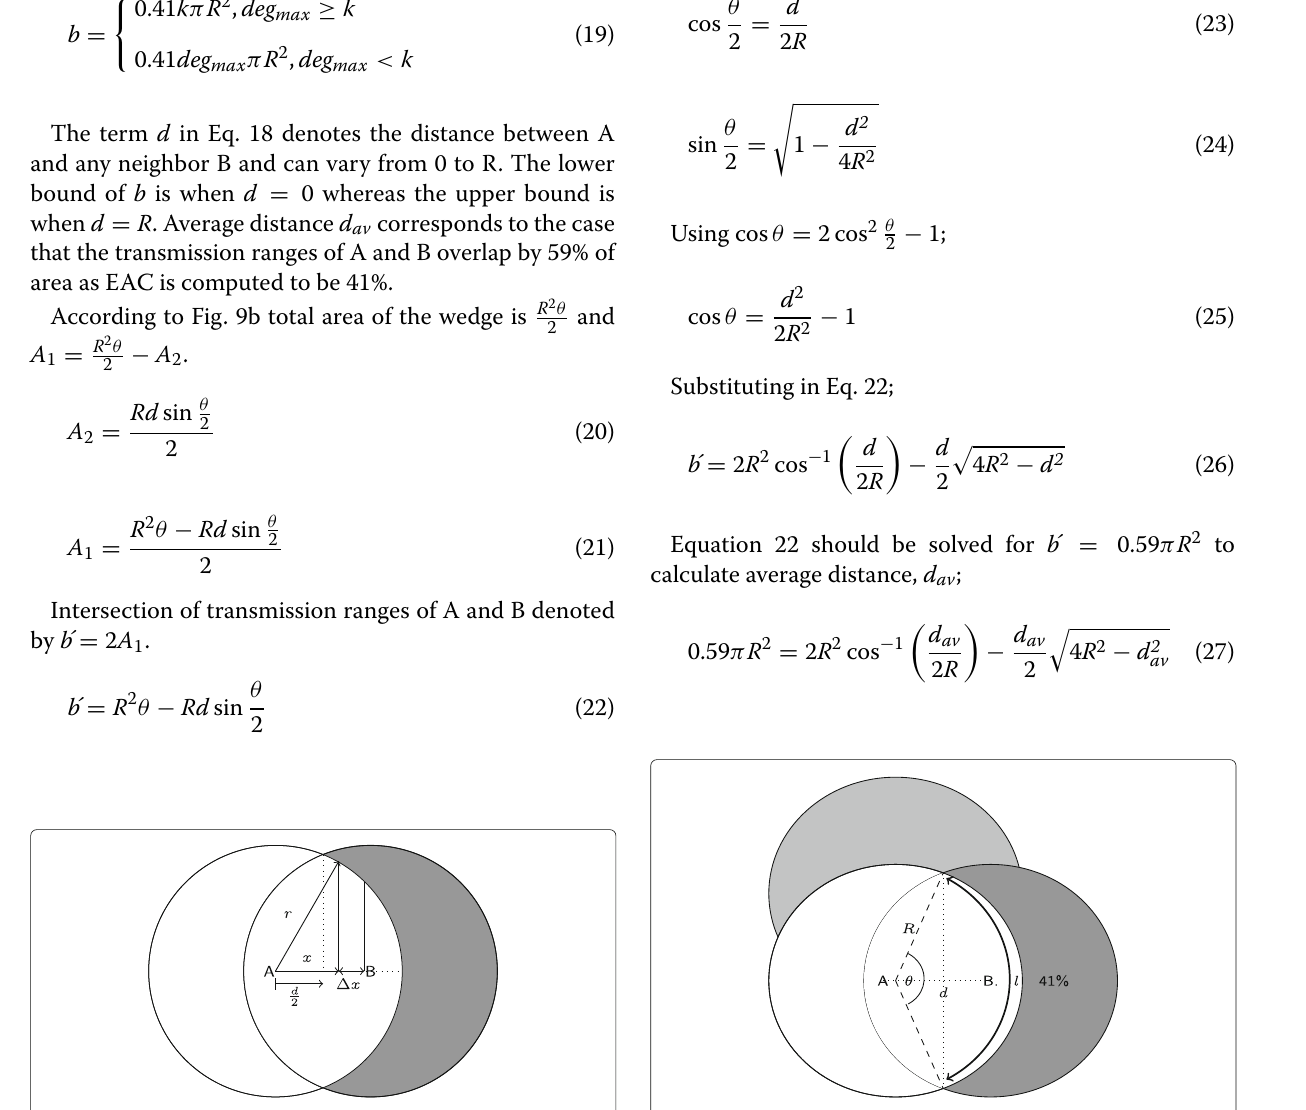
Fig. 8 Estimating the average area covered by rebroadcast level